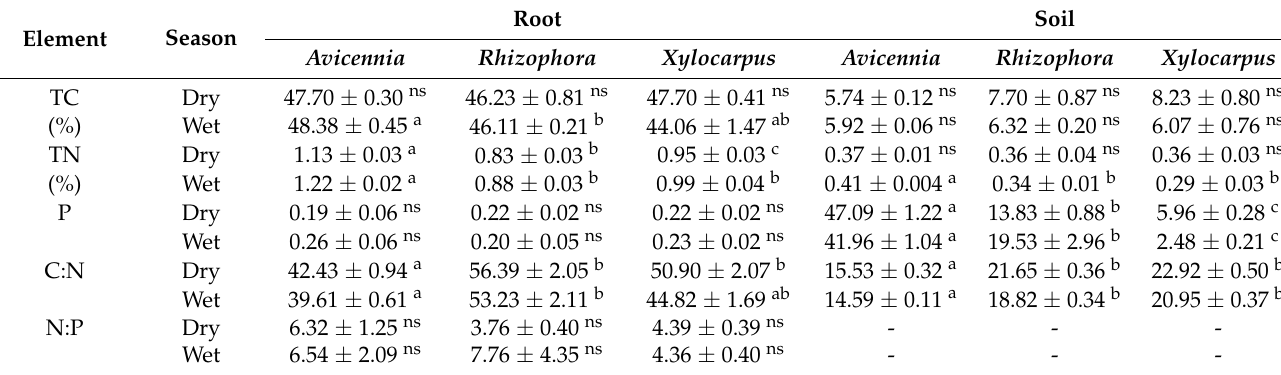
Table 1. The values of nutrient concentrations of root and soil samples (mean ± SE) across the vegetation zones during the dry and wet seasons with the results of statistical analysis showing the effects of zonation. The P contents in root tissues and soil were TP (%) and available P (mg · kg − 1 ),